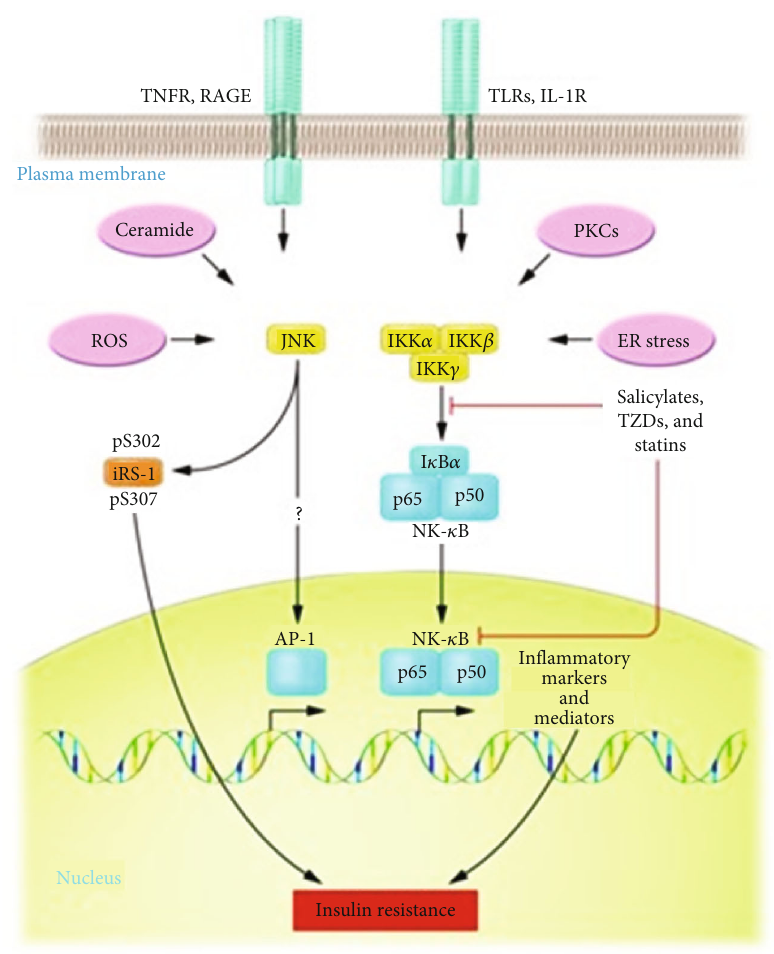
Figure 3: An explanatory graph of the di ff erent molecular pathways referring mainly to the blockade of the insulin receptor ISR-1 by in fl ammatory mediators